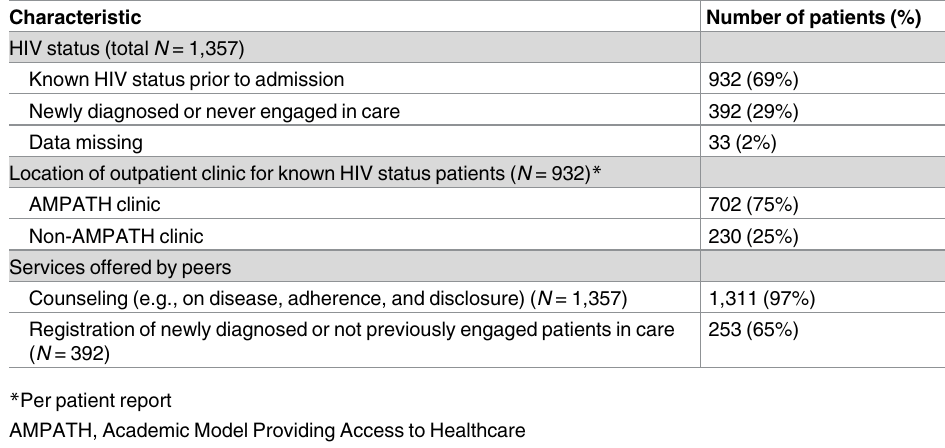
Table 1. Peer navigator program preliminary